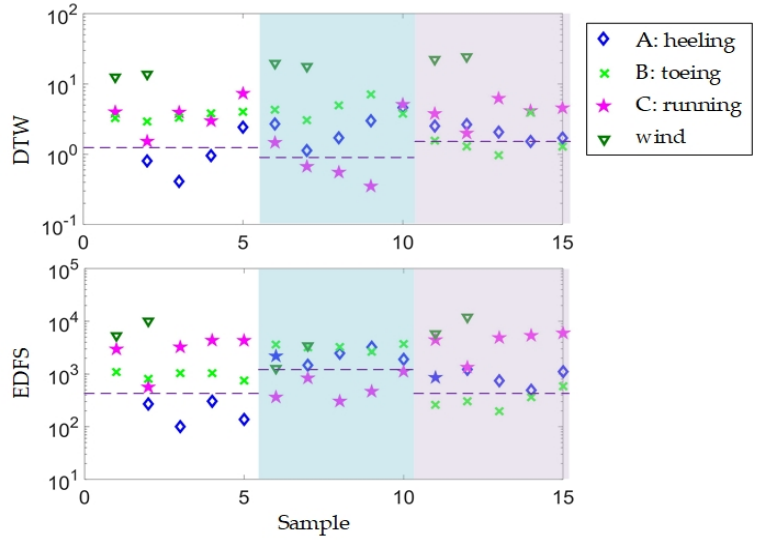
Figure 19. Recognition results with EDFS and DTW. Reproduced with permission from our previous paper [84].